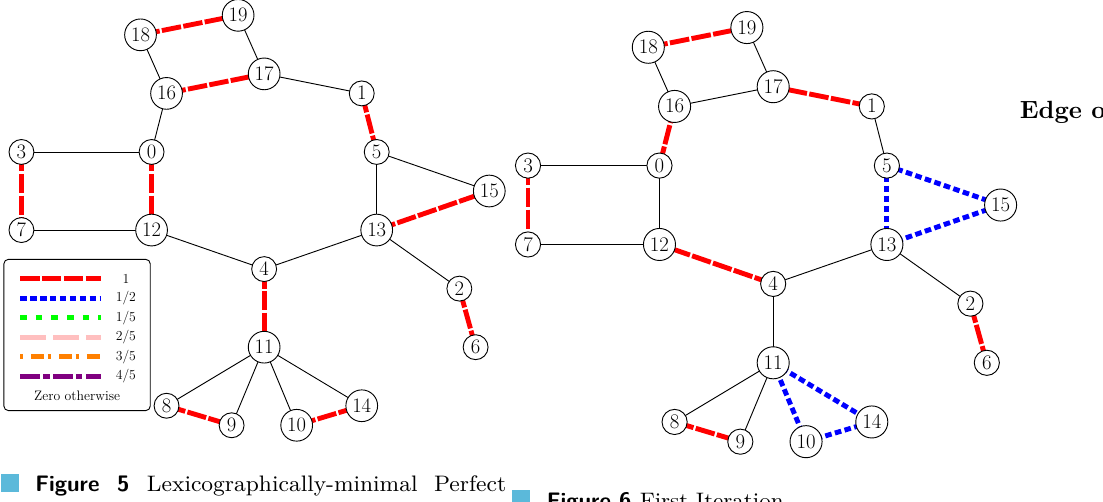
Figure 6 First Iteration